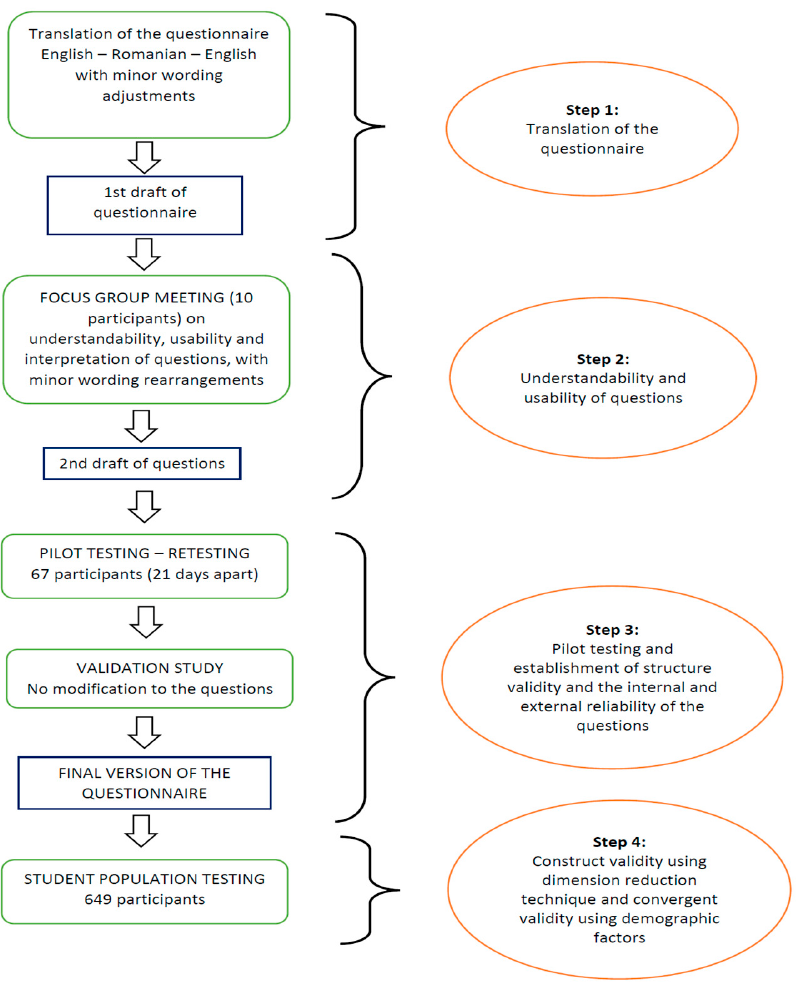
Figure 1. Flow diagram for the steps undertaken for validity testing of Toronto Empathy Questionnaire among Undergraduate Medical Students.